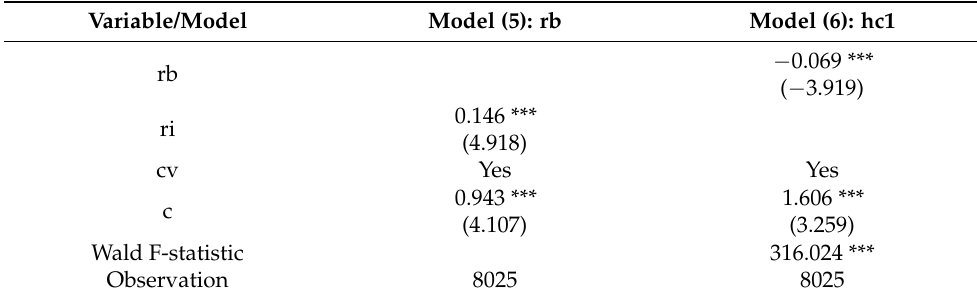
Table 5. Results of robustness test (two-stage least